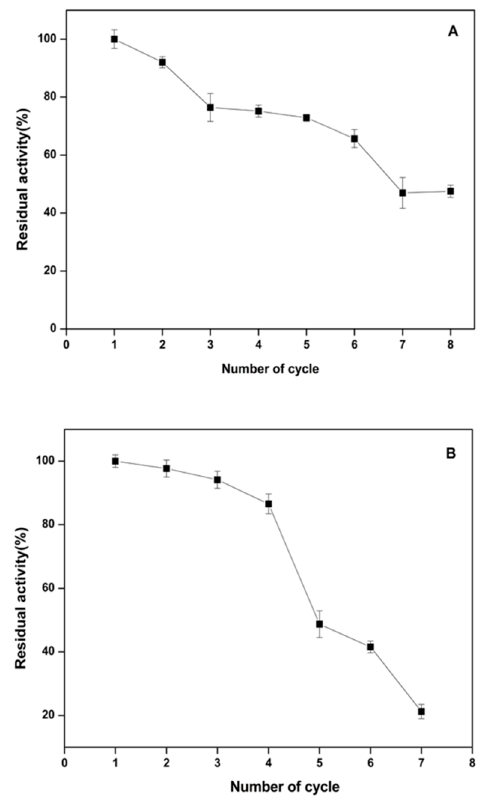
Figure 7. Operational stability of immobilized PLD a2 in subsequent cycles of hydrolysis activity ( A ) and transphophatidylation ( B ).